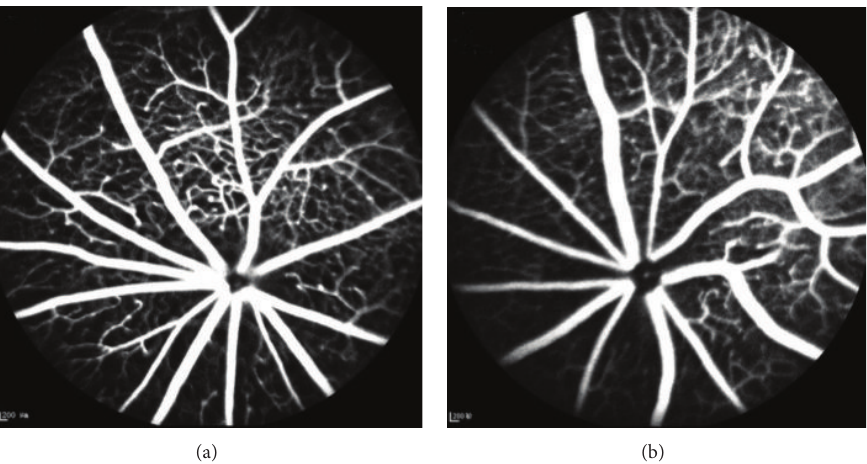
Figure 4: No evident retinal vascular changes were observed in db/db mice by FFA. FFA image in db/db mice (a) and db/+ mice (b) at 28 weeks. Neither of them presented abnormal alterations on retinal vascular structures.